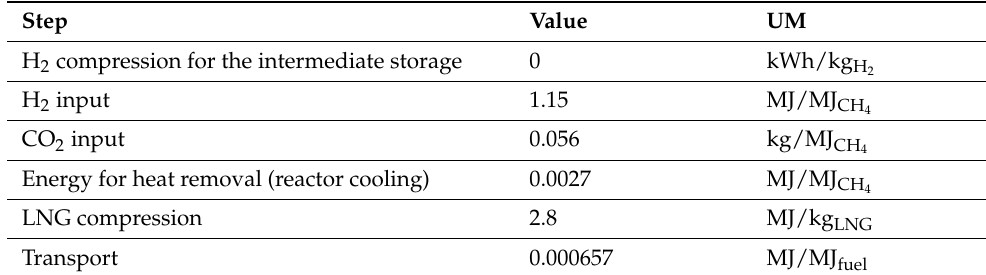
Table A2. Main inputs for eLNG